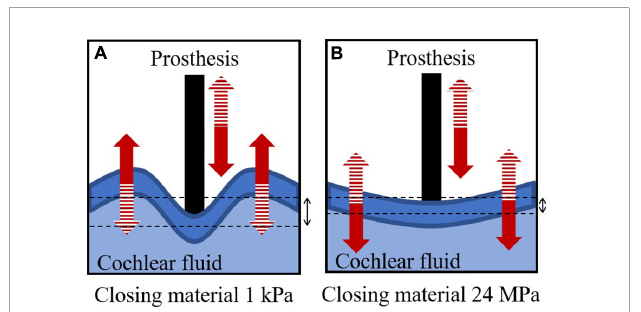
FIGURE6 Descriptions of cochlear fluid, prosthesis, and closing material in stapedectomy when the Young’s modulus of the closing material is (A) 1 kPa and (B) 24 MPa. The solid and dashed patterns in the arrows represent the same phase of